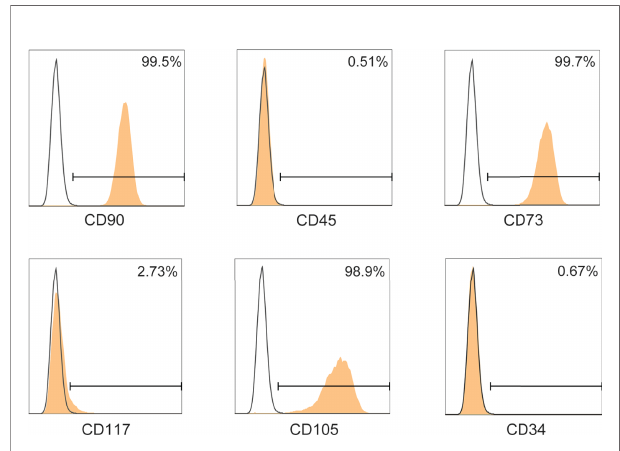
FIGURE 1 | Phenotypic characterization of ADMSCs. Surface determinants of ADMSCs assessed by fl ow cytometer. Black lines represented the isotype